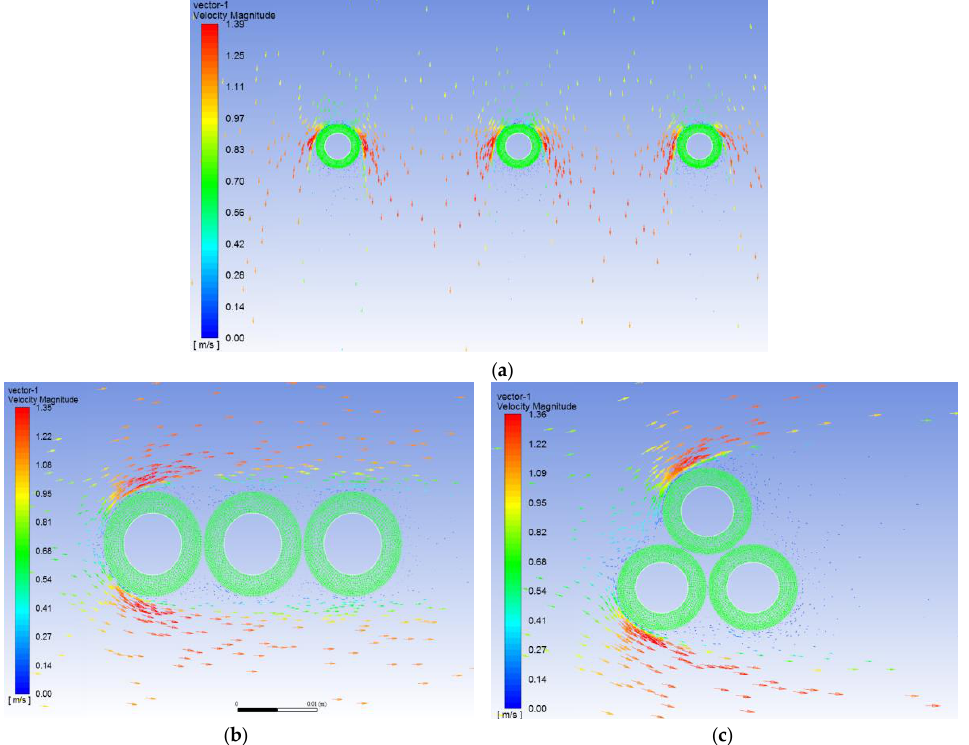
Figure 6. Distribution of air velocity vectors: ( a ) cables in flat formation with 50 mm spacing as in Figure 4. ( b ) cables in flat formation without spacing as in Figure 4a; ( c ) cables in trefoil formation without spacing as in Figure 4c.